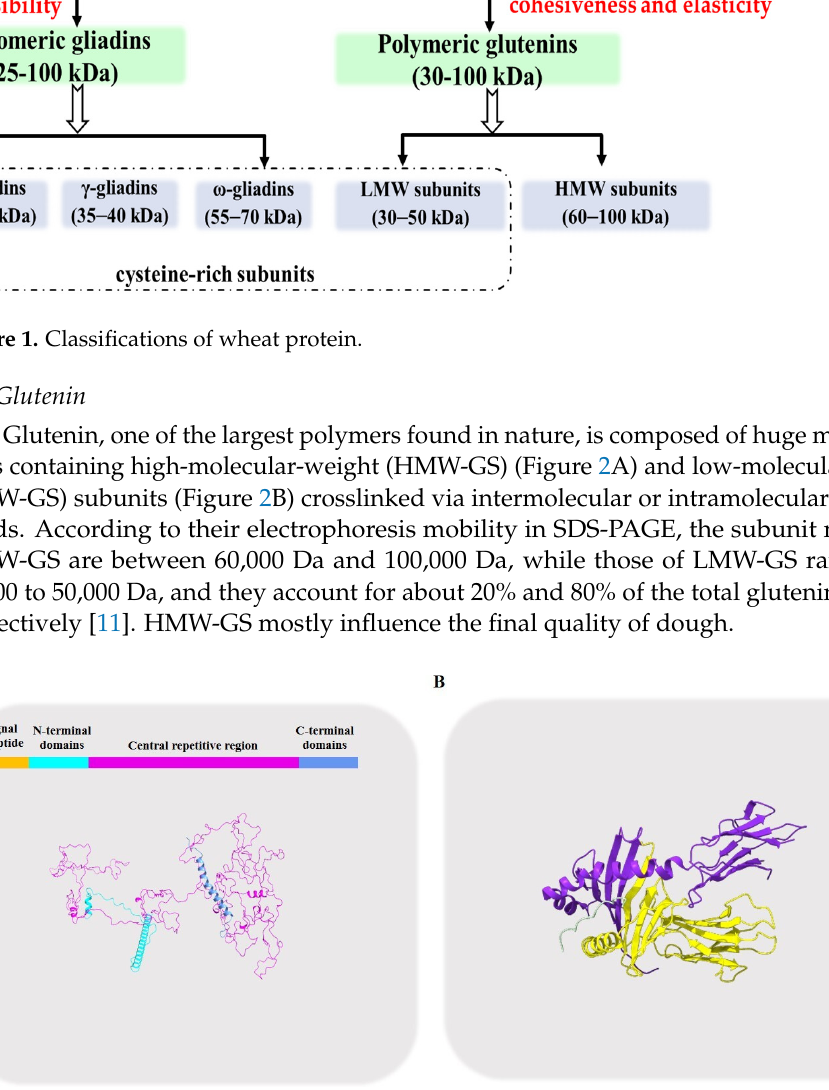
Figure 2. Structure of glutenins. ( A ) Predicted structure of HMW-GS; ( B ) Crystal structure of LMW-GS (PDB: 6px6). The yellow and purple colors show two subunits of